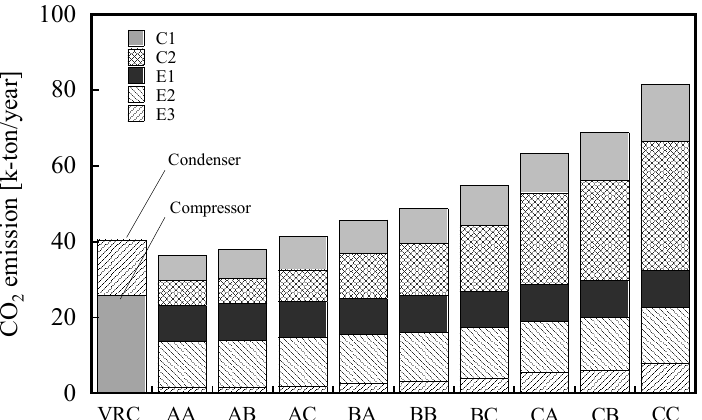
Figure 5. CO 2 emissions from the two-stage membrane process with various combinations. C1 and C2 are the compression of the permeate stream using electricity. E1 is the feed heating using steam. E2 and E3 represent the cooling of the compressed permeate streams using refrigerated water.